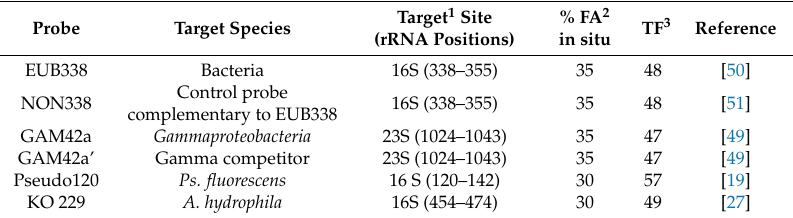
Table 1. Oligonucleotide probes used for bacteria determination by hybridization in situ (FISH) method during farming of European grayling ( Thymallus thymallus L.) broodstock in